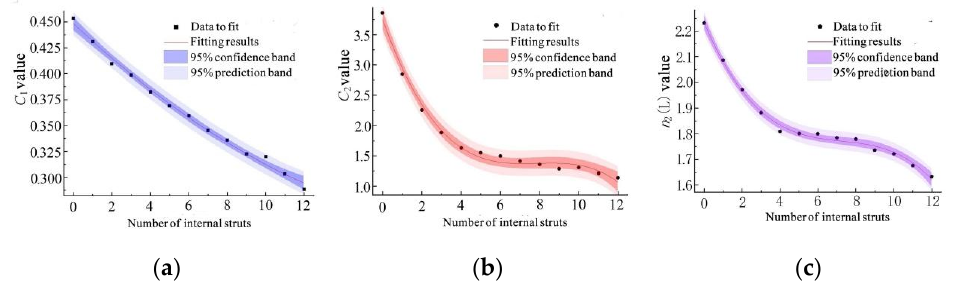
Figure 9. Relevant parameter values and fitting results: ( a ) C 1 ( L ) fitting results; ( b ) C 2 ( L ) fitting results; ( c ) n 2 ( L ) fitting results.